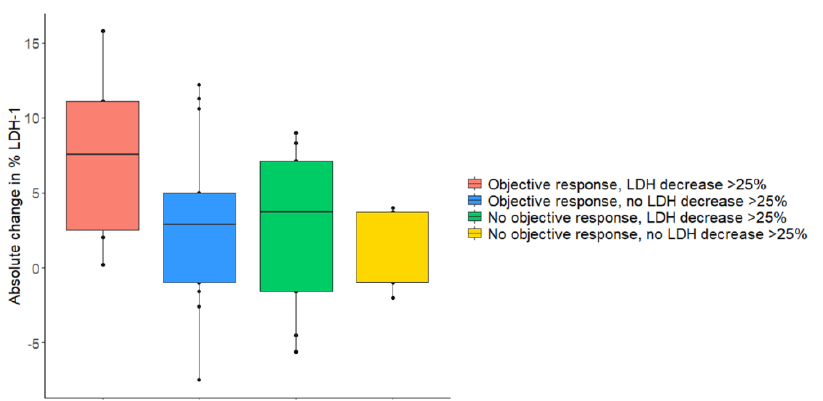
Figure 6. Changes in LDH-1 during therapy. The absolute changes in the percentage of LDH-1 are shown in the figure. Patients are grouped based on whether or not they had an objective response and/or a 25% decrease in total LDH levels at the time of on-treatment blood